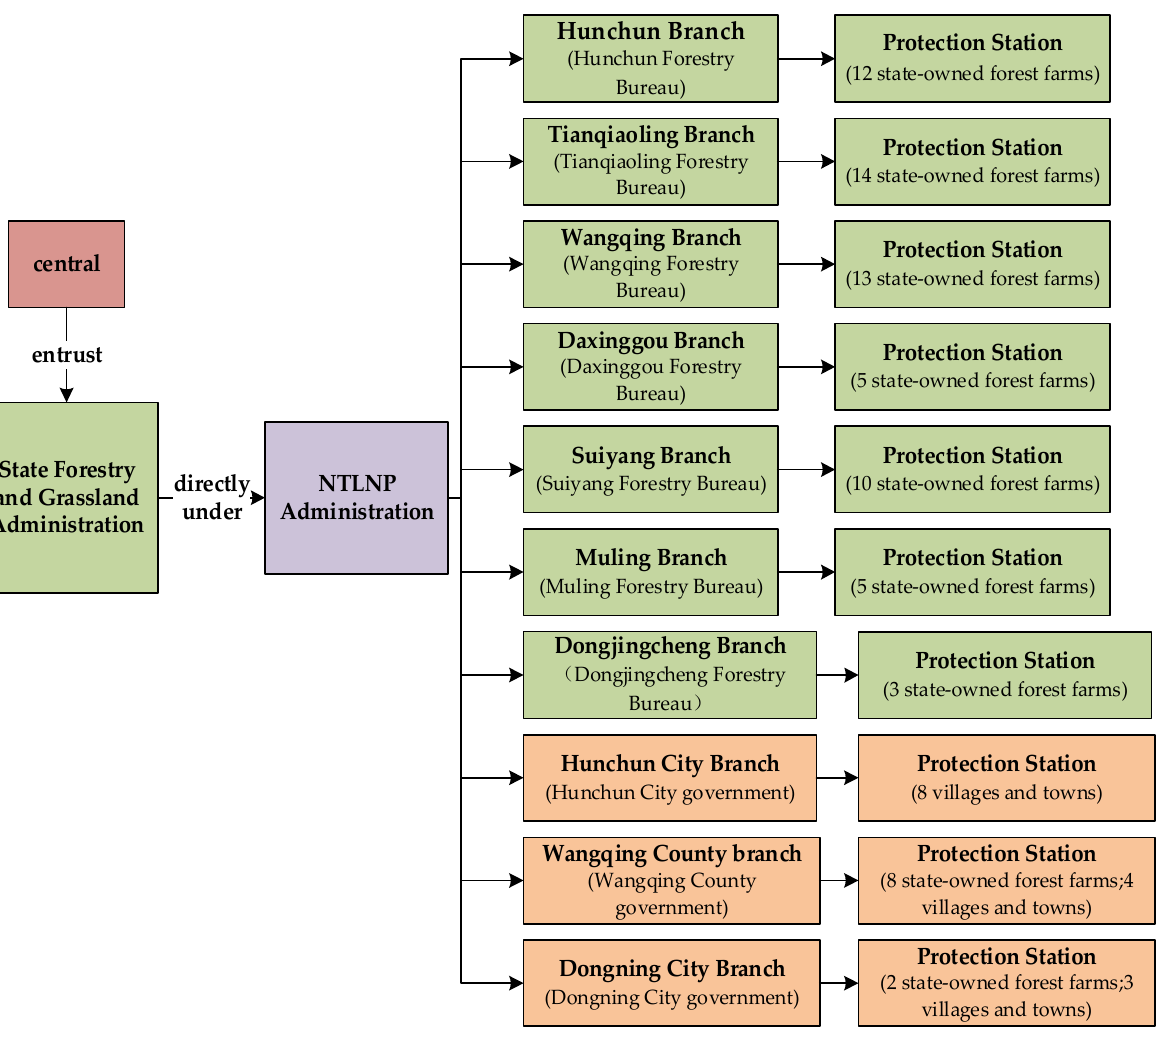
Figure 1. Organizational structure of the vertical management system of the NTLNP.